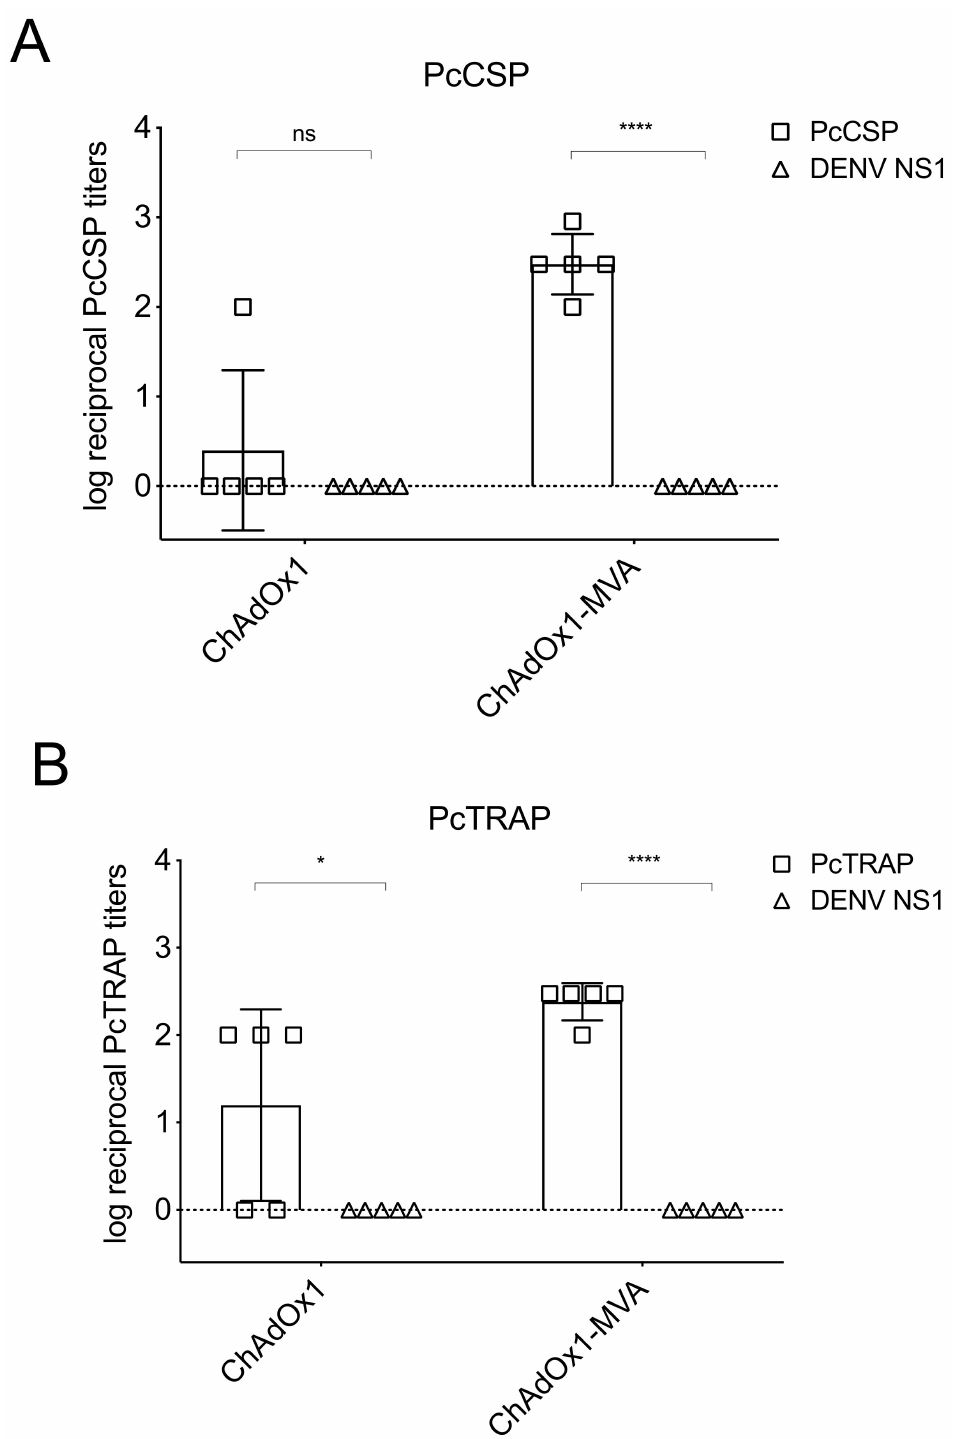
Figure 5. Humoral immune responses elicited by ChAdOx1 / MVA vaccines in rhesus macaques. A group of rhesus macaques ( n = 5) were co-immunized with ChAdOx1 PcCSP and ChAdOx1 PcTRAP at 1 × 10 10 iu and the control group ( n = 5) were immunized with unrelated ChAdOx1 DENV NS1 vaccine. Eight weeks after prime vaccination, the animals were boosted with MVA encoding the same antigens. Plasma samples were collected at 8 weeks after prime immunization and 2 weeks after P-B immunization. Antibody responses elicited by vaccines were quantified by ELISA in plates coated with a PcCSP ( A ) or PcTRAP ( B ) proteins. p -values were determined by unpaired t-test. p > 0.05 (ns), p < 0.05 (*), p < 0.01, p < 0.001, p < 0.0001